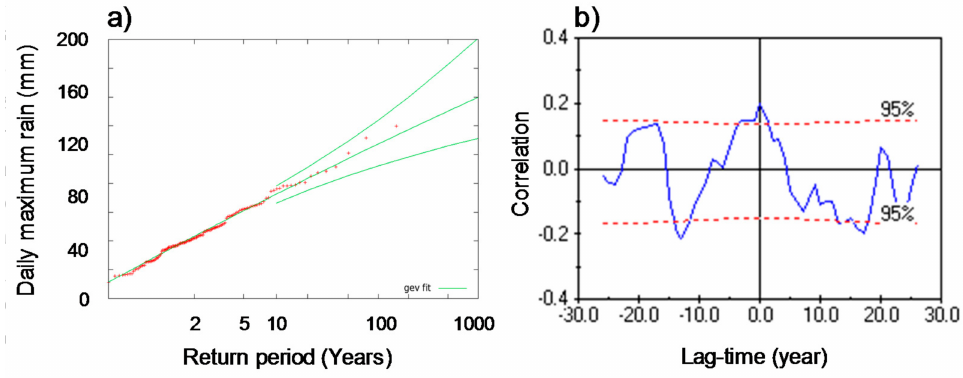
Figure 6. ( a ) Return period of daily maximum rainfall in Naples by GEV (generalized extreme value) distribution; ( b ) Cross-correlation between smoothed maximum rainfall and teleconnection index (Pacific Decadal Oscillation (PDO) + (6 + AMO) 0.5 ). Note that the cross-correlation goes beyond the critical value at lag =